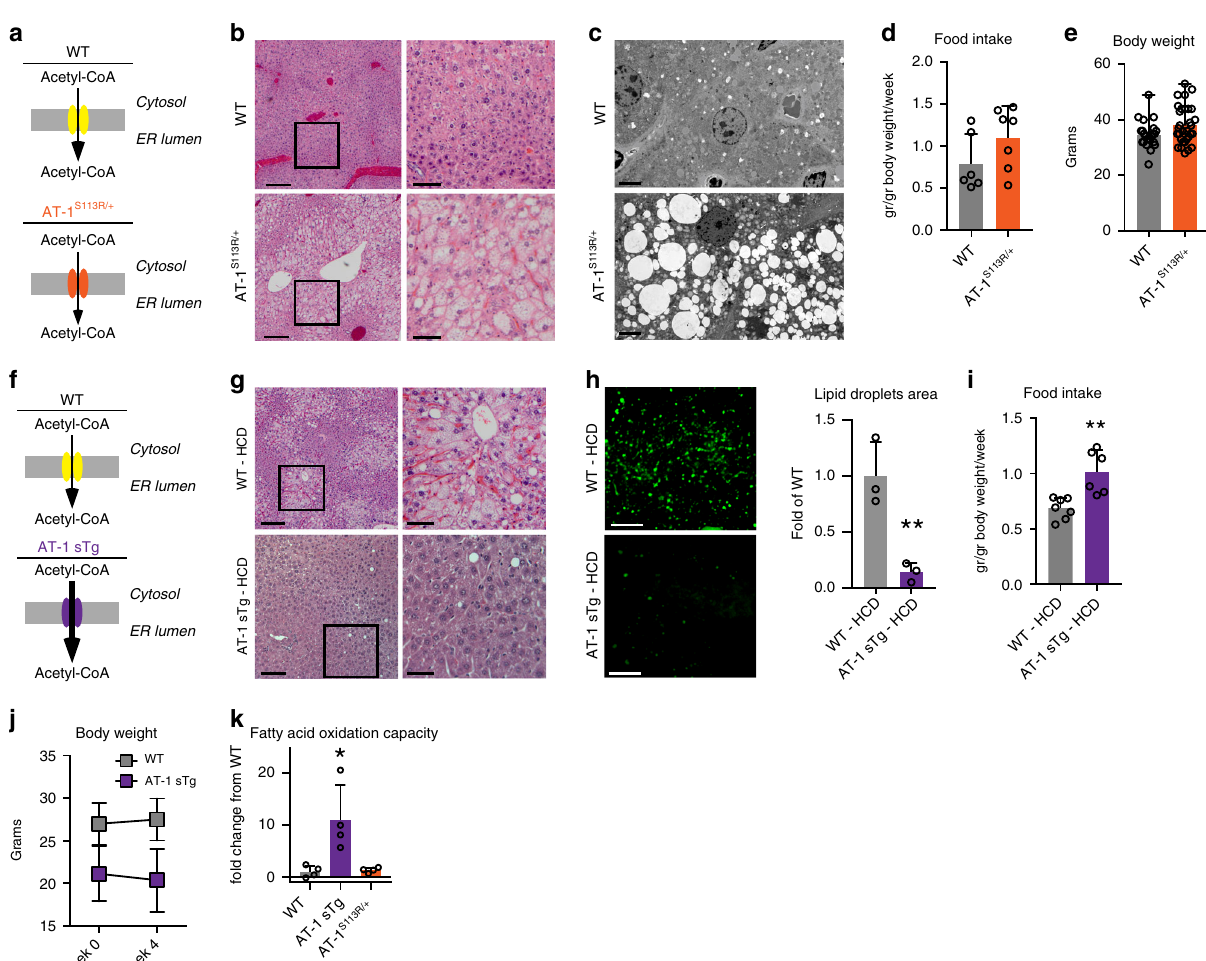
Table 1 Hepatic lipid content in WT and AT-1 S113R/ + mice fed standard diet Cytosolic acetyl-CoA (nmol/g tissue)